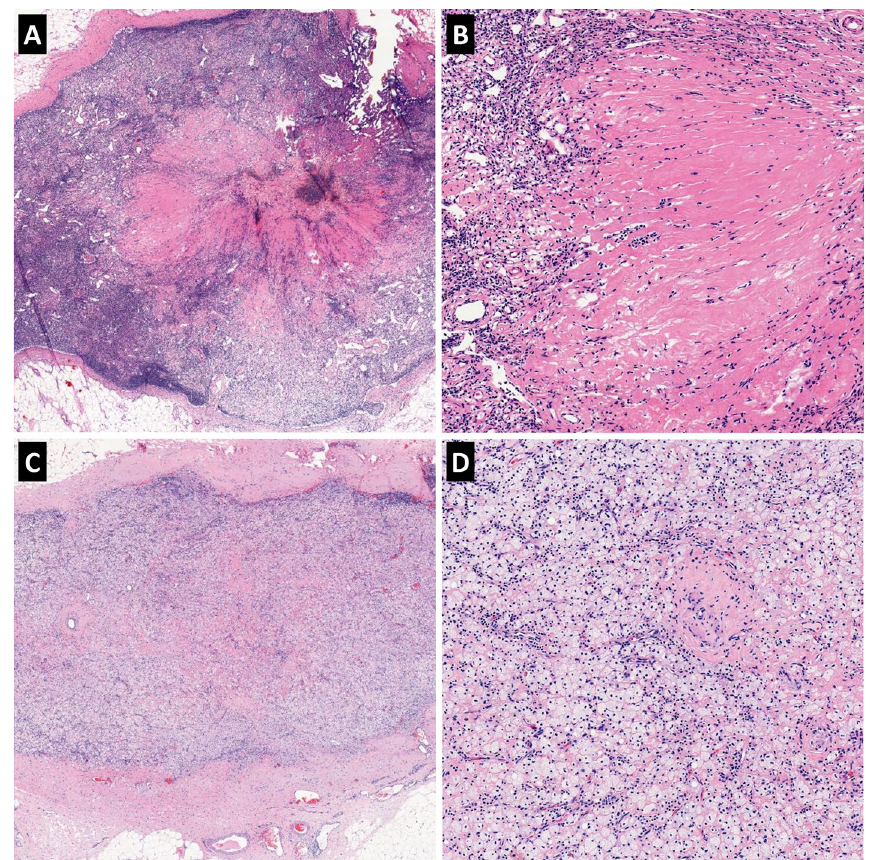
Figure 1. Representative images of complete tumor regression in axillary lymph nodes. (A) A large area of intranodal fibrosis is noted in the center of lymph node. (B) Magnification of A reveals depletion of lymphocytes and replacement with dense fibrous tissue. (C) Nodal architecture is obliterated with infiltration of foamy histiocytes and intranodal fibrosis. Thickened lymph node capsule is also found. (D) Magnification of (C) shows heavy infiltration of foamy